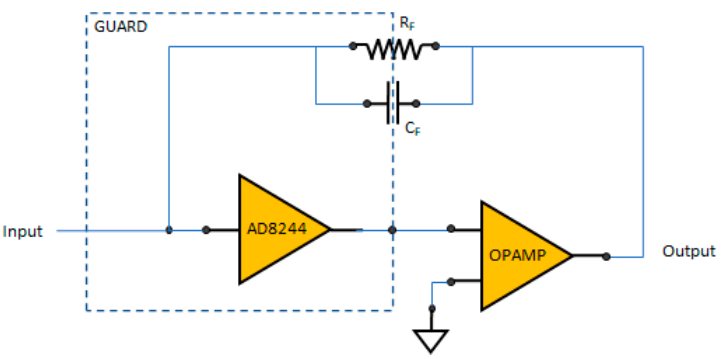
Figure 5. Composite amplifier